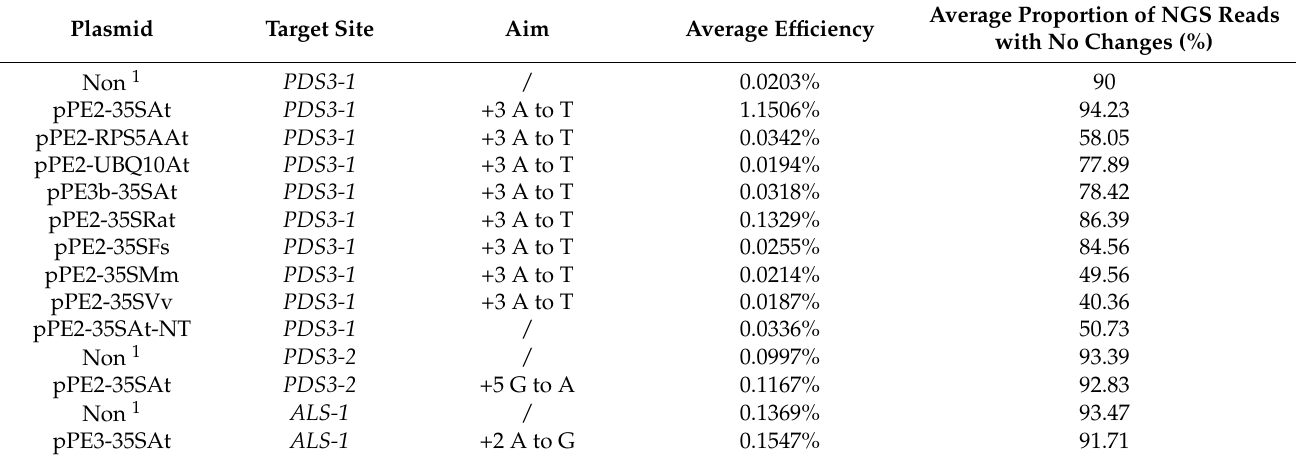
Table 1. Efficiencies of various prime editors in protoplasts of Arabidopsis thaliana